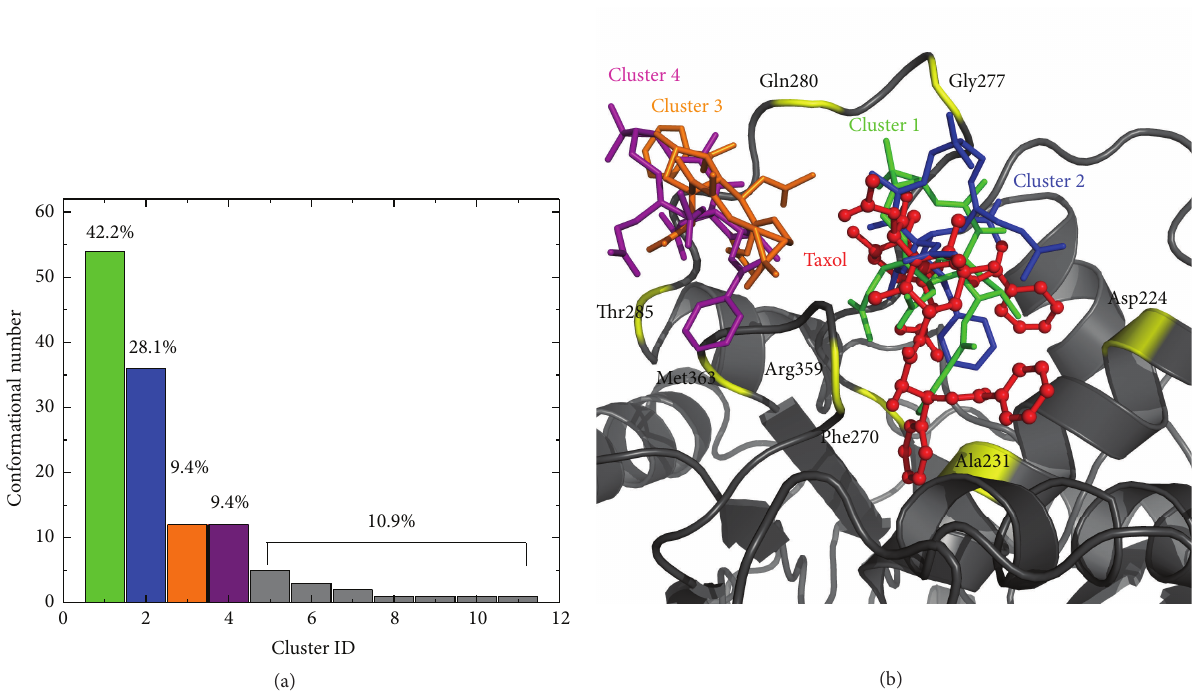
Figure 4: The docking result of L713283 with 𝛽 -tubulin. (a) The docked conformations were clustered with the RMSD cutoff value of 0.2 nm. (b) The binding modes of both L713283 docked conformations and the crystal structure of Taxol ligand. Taxol ligand is represented using ball-and-stick model in red. The representative docked conformations of L713283 are shown with stick model in green, blue, orange, and purple,